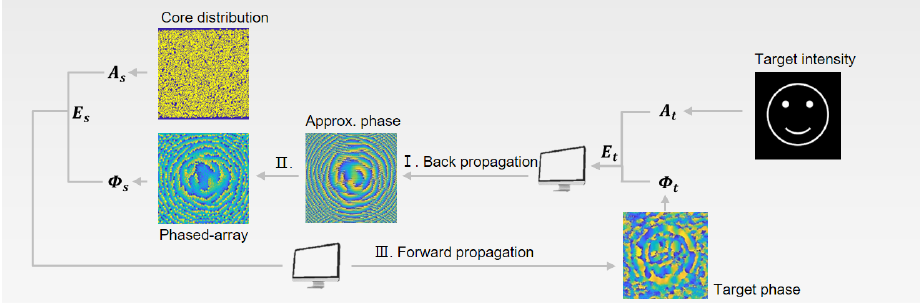
Figure 4. Principle of the Core-GS algorithm. Intensity distribution and a random phase constitute the light field at the target plane, which is numerically back propagated to the source plane for retrieving the approximated phase at the source plane. A core distribution map is applied on both amplitude and phase image at the source plane for better simulation of the light propagation through the MCF. The complex light field is then forward propagated to the target plane to get the approximated phase image, which is used to constitute the complex light field at the target plane for the next iteration. The iteration stops while the correlation between forward propagated and the targeted intensity distribution reaches the threshold.